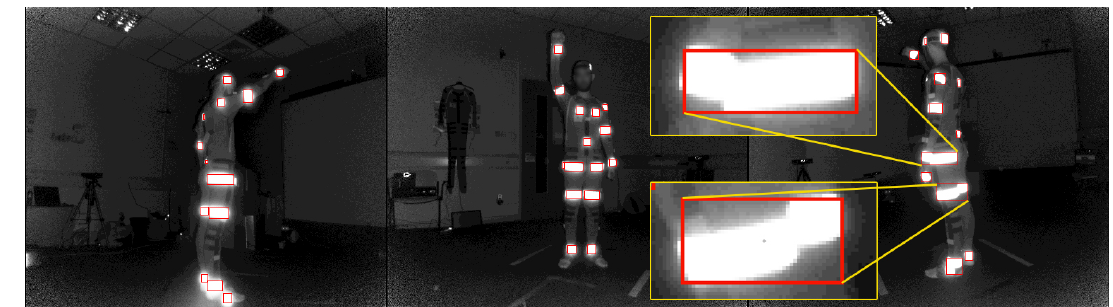
Figure 10. Reflector annotation using blob tracking on IR binary mask, visualized though on I v data for the sake of better understanding. Erroneous estimates occur when reflector regions are